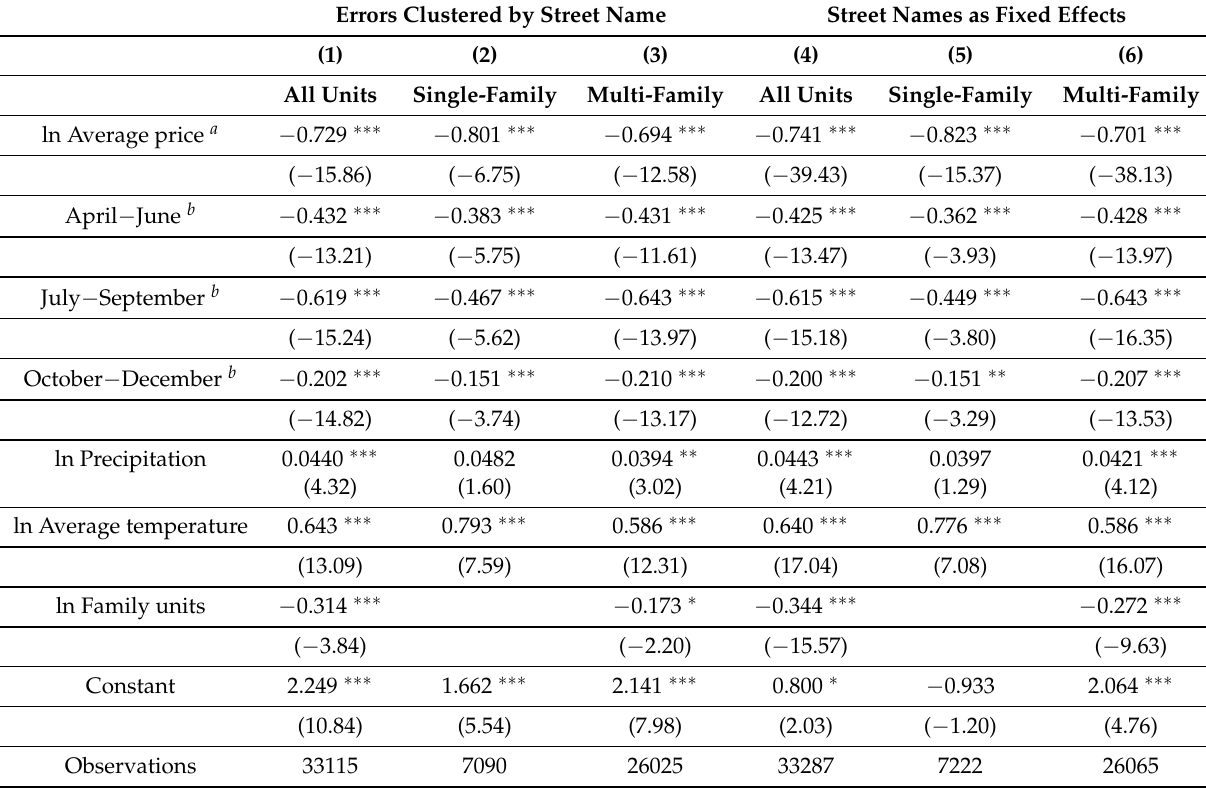
Table 3. Panel data regression. Dependent variable is logarithm of water consumption per family unit per